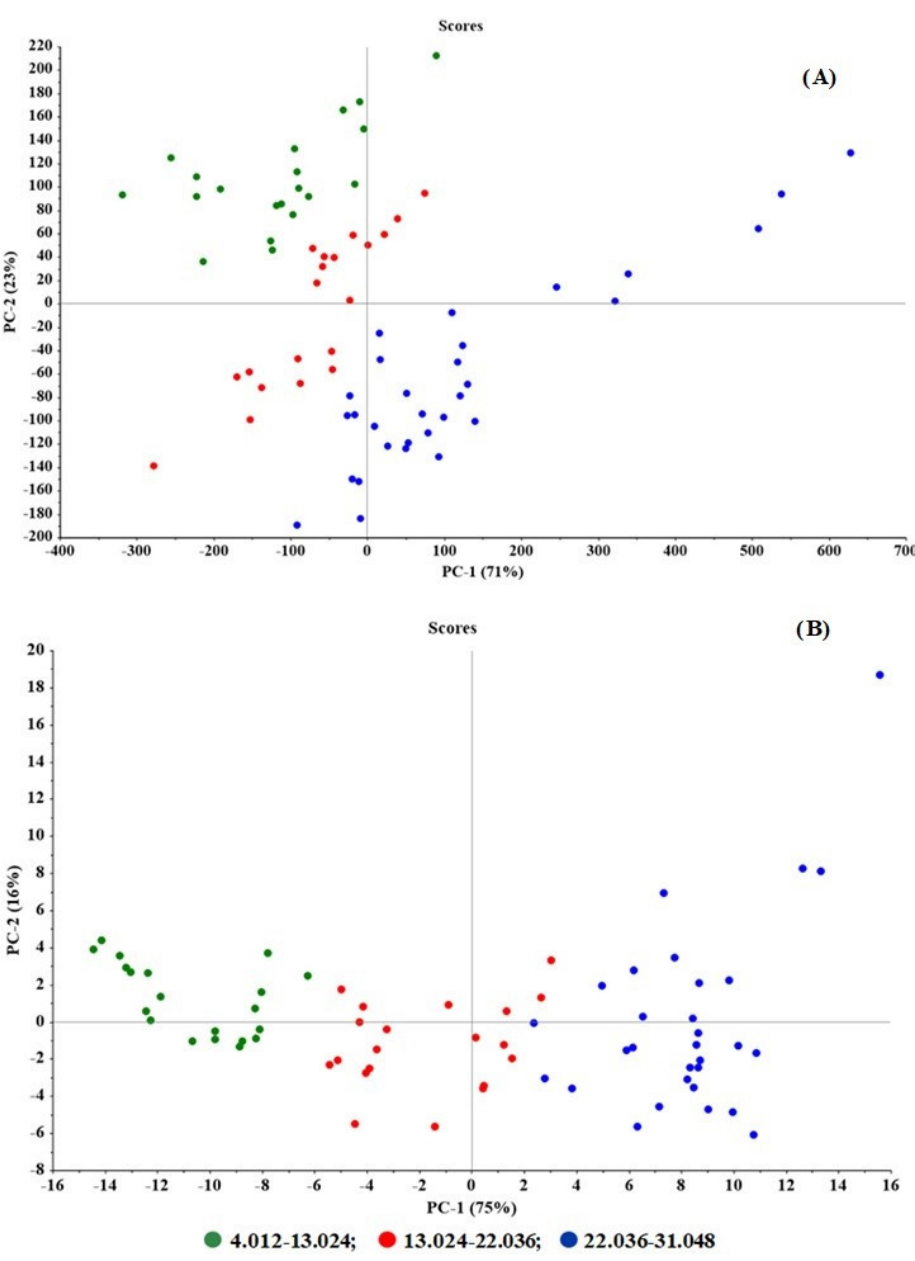
Figure 5. Score plots of ( A ) original data and ( B ) the pretreated data (SNV + 1st derivative) of the best model for granules. The data grouping by concentrations along with PC1 was clearly seen from the pretreated data compared the original data.